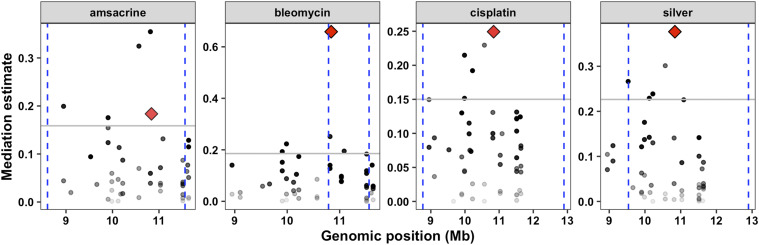
Mediation analysis for the eQTL hotspot on the center of chromosome V. Mediation estimates calculated as the indirect effect that differences in expression of each gene plays in the overall phenotype (y-axis) are plotted against the genomic position of the eQTL (x-axis) on chromosome V for 49 probes (including scb-1 (red diamond)) that map to the chromosome V eQTL hotspot (set 1 RIAILs). A representative trait for each drug from the set 1 linkage mapping analysis are shown: amascrine (median.EXT), bleomycin (median.EXT), cisplatin (median.TOF), and silver (median.norm.EXT). The 90th percentile of the distribution of mediation estimates for each trait are represented by the horizontal gray lines. The confidence intervals for the QTL (set 1 RIAILs) are shown with the vertical blue dotted lines. The confidence of the estimate increases (p-value decreases) as points become less transparent.